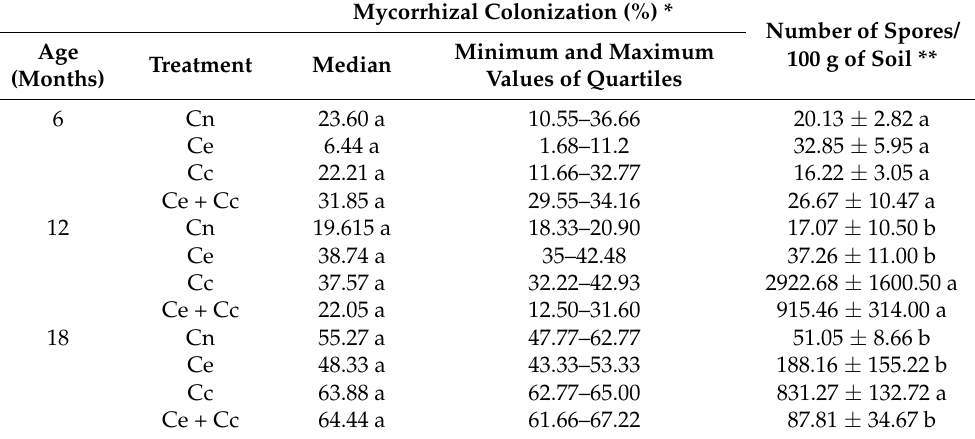
Table 1. Mycorrhizal colonization (%) and the number of spores of arbuscular mycorrhizal fungi (AMF) per 100 g dry soil. Colonization of Agave maximiliana by the consortium of autochthonous AMF of (1) the A. maximiliana rhizosphere (Cn) and the allochthonous AMF of (2) Claroideoglomus etunicatum (Ce), (3) Claroideoglomus claroideum (Cc), and (4) C. etunicatum + C. claroideum (Ce + Cc) at 6, 12, and 18 months under greenhouse